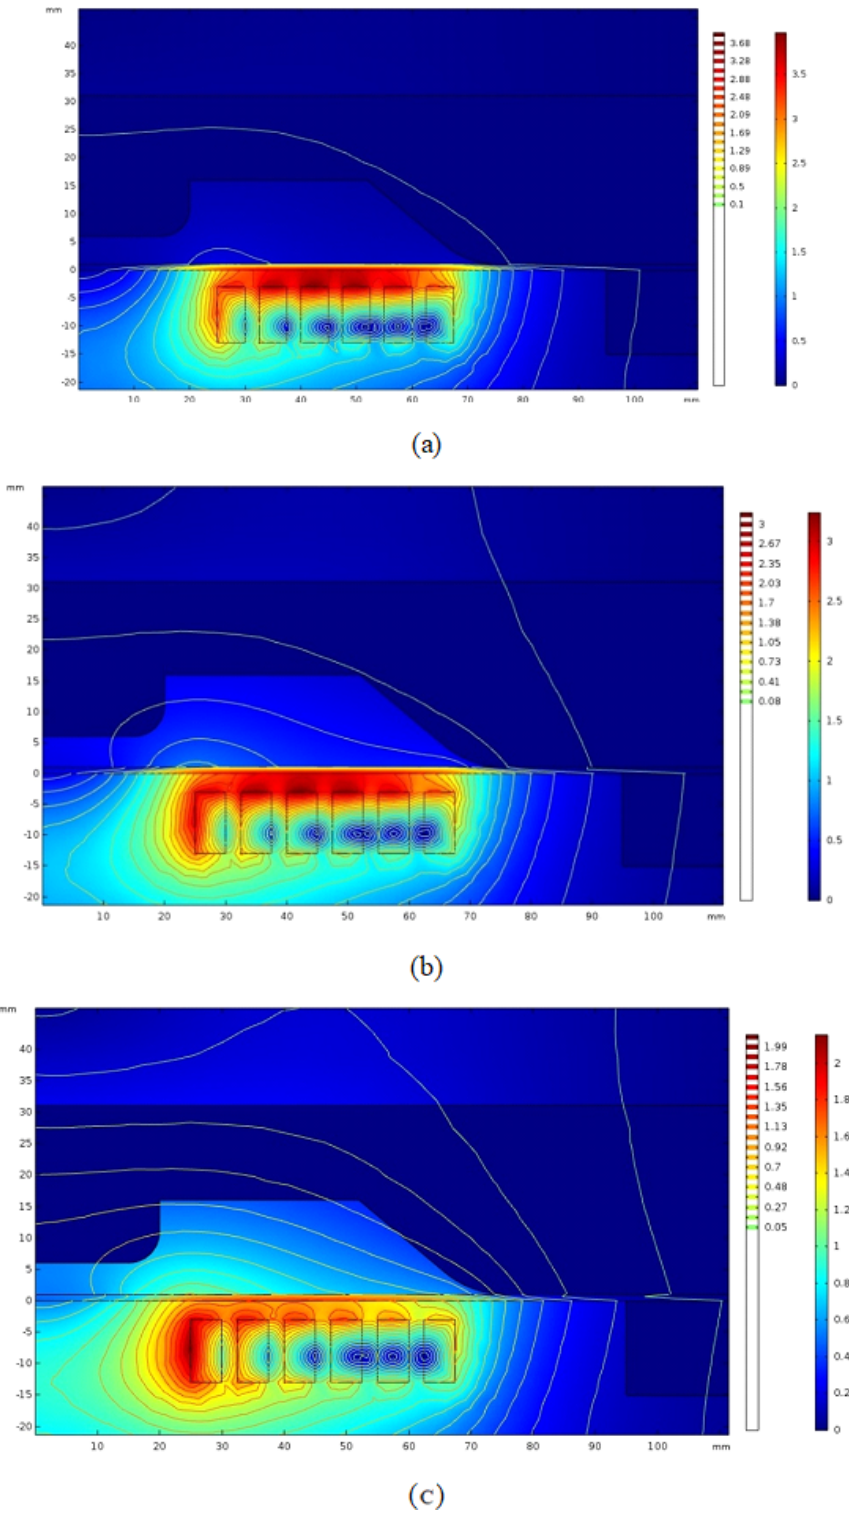
Figure 9. (a) Magnetic field at time step 100µs (voltage = 2400, sheet = 1.02mm, N = 6). (b) Magnetic field at time step 190µs (volt- age = 2400, sheet = 1.02mm, N = 6). (c) Magnetic field at time step 315µs (voltage = 2400, sheet = 1.02mm, N =